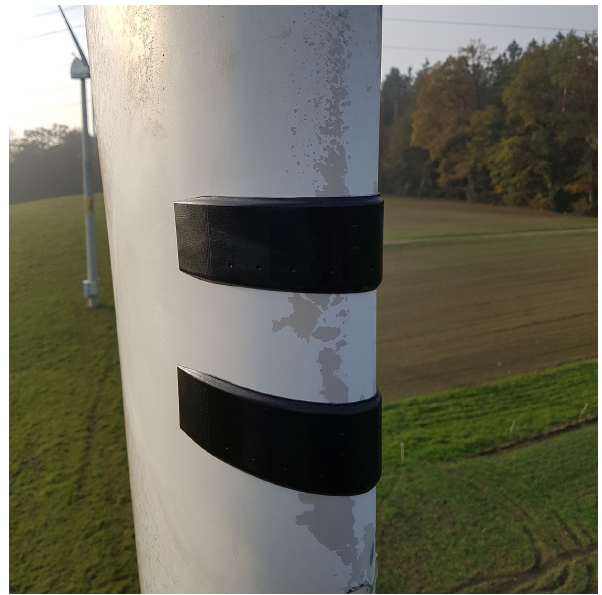
Figure 5. PolyJet 3D-printed housings glued on a 6kW operating wind turbine to test its